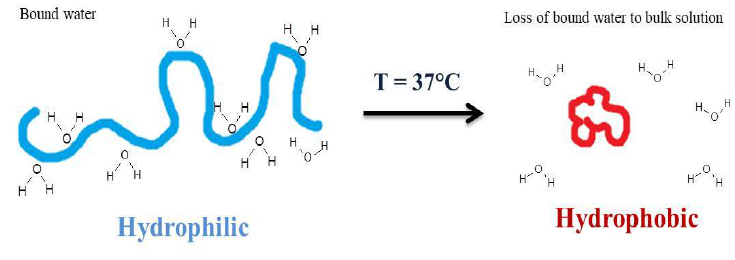
Figure 7. Scheme of the oxi-HA/ADH hydrogel thermoresponsive